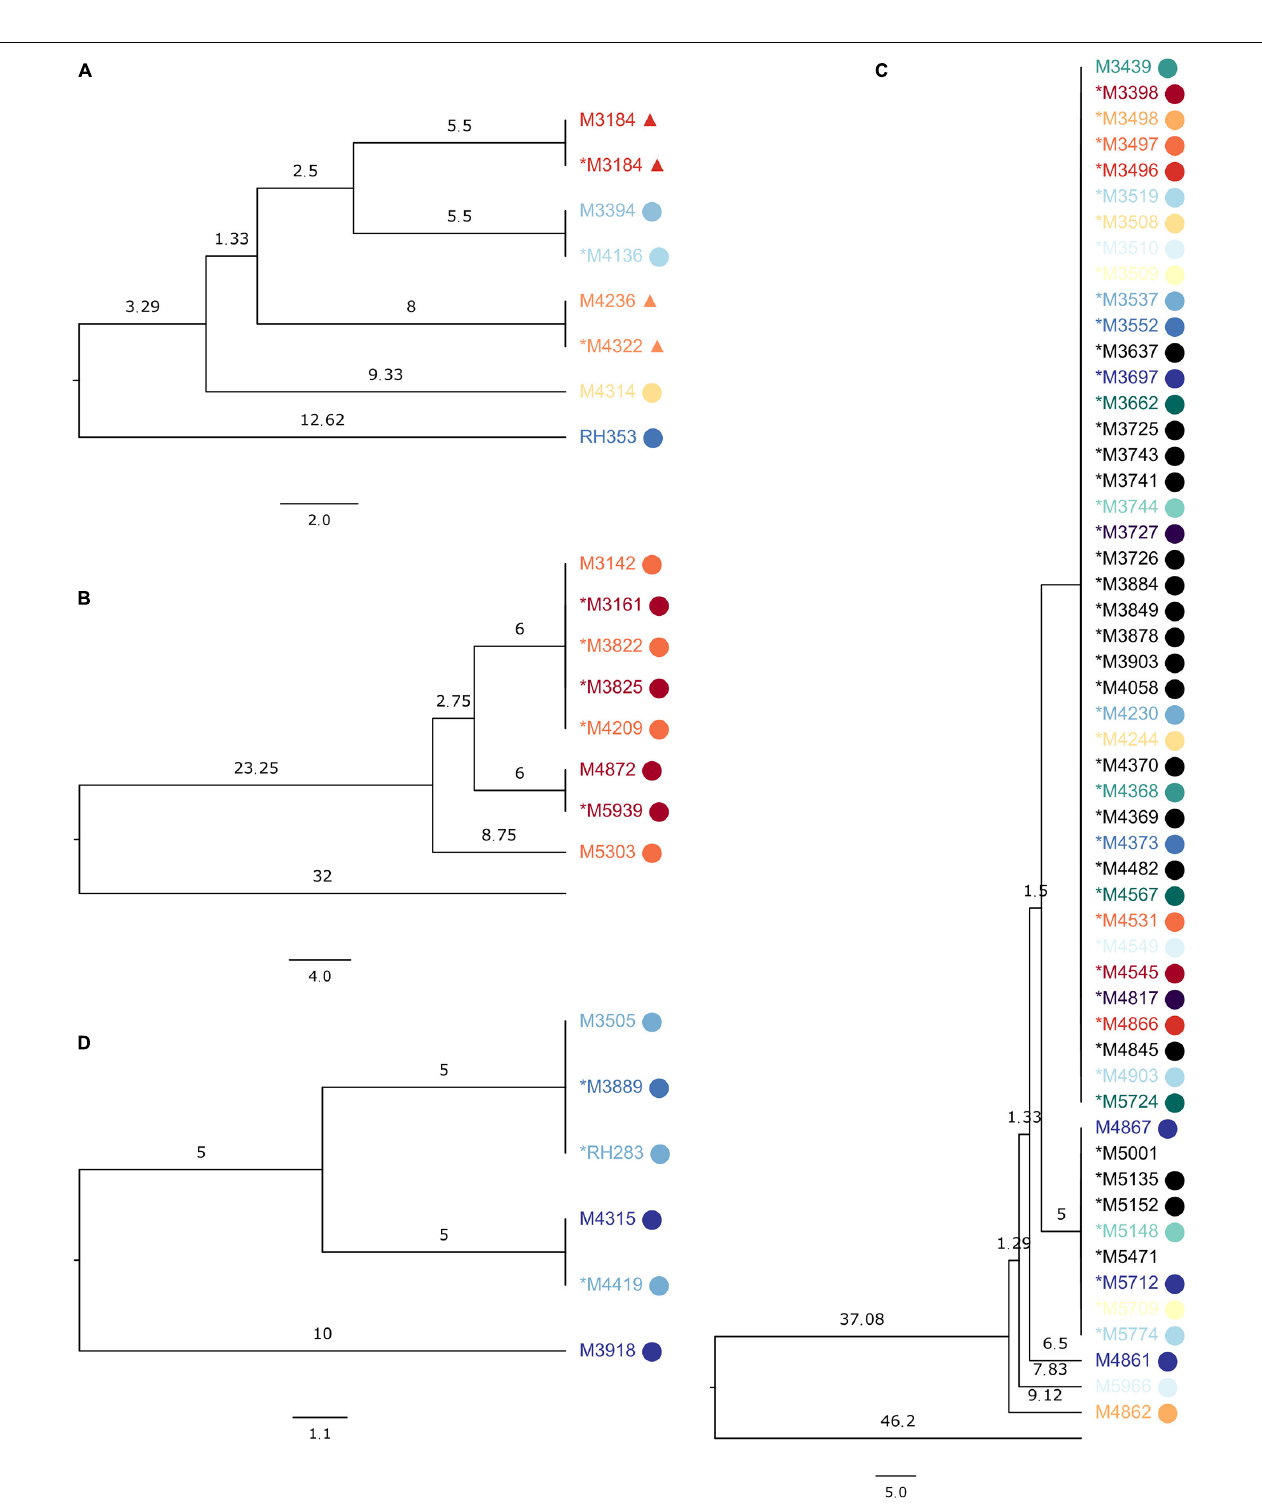
FIGURE 1 | Subsections of the UPGMA tree made on the reference sequence Staphylococcus aureus subsp. aureus 11819-97, showing SeqSphere+ clusters, with samples from the same patient colored the same and epidemiologically related samples displaying the same symbol. The asterisk denotes samples in the technical clusters. Branch lengths are single nucleotide differences. (A) ST1 clusters with seven samples; the sequences clustered were from the same biological sample or from patients sharing a household (labels marked with circle or triangle) or from the same patient. (B) ST1 cluster with eight sequences from the same household. (C) ST1 cluster with 51 sequences from members of connected families and unrelated individuals. (D) ST852 cluster with six sequences from the same household.